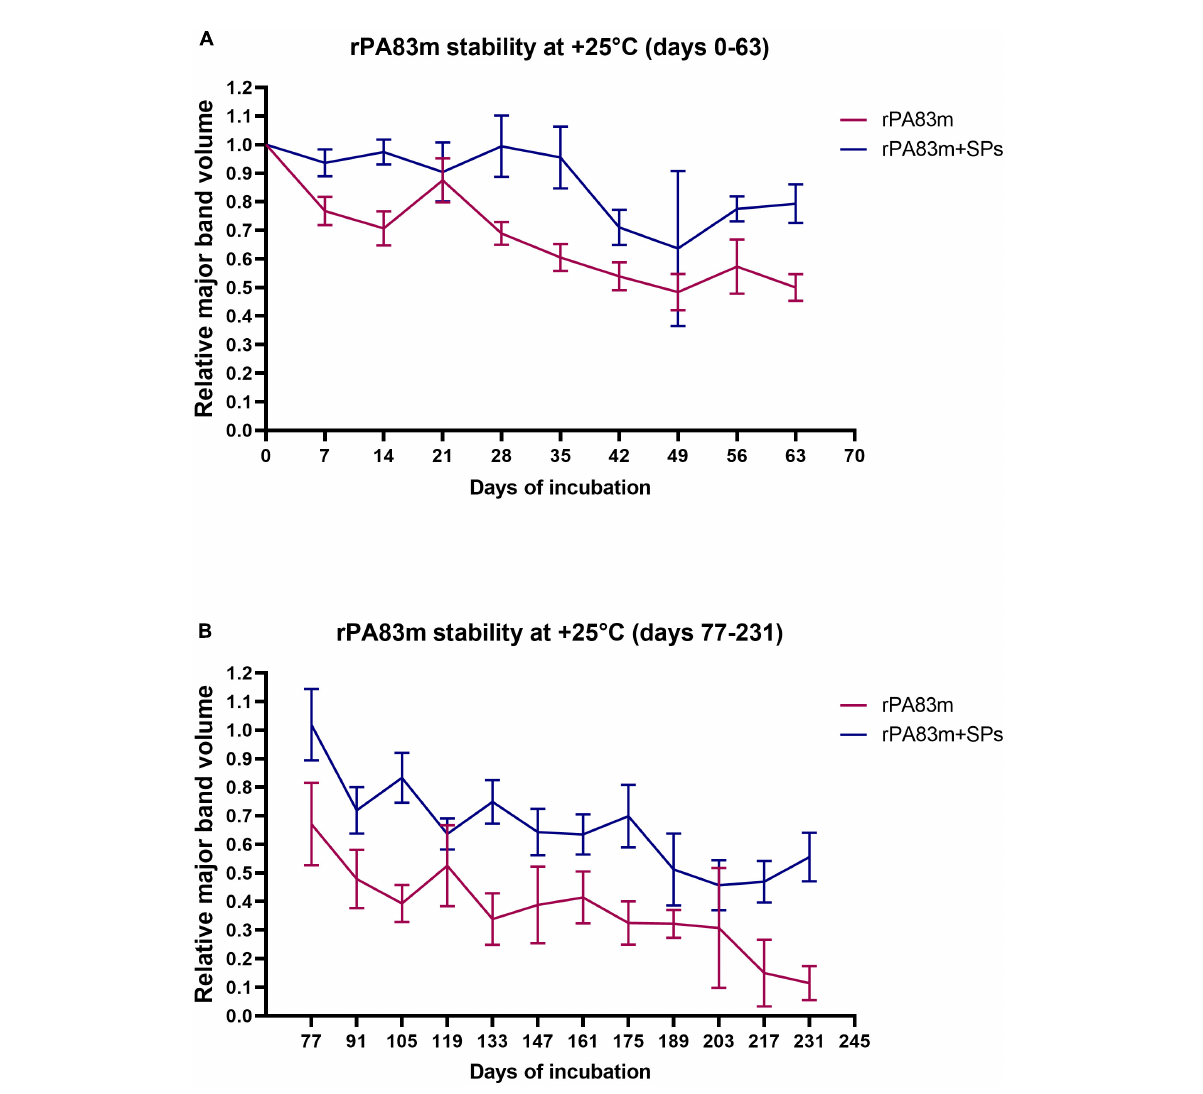
FIGURE2 Stability of individually formulated rPA83m and rPA83m as a part of rPA83m + SPs compositions at +25 ◦ C. Two independent stability evaluation experiments were carried out: for days 0–63 (A) and for days 77–231 (B) . In each experiment individually formulated rPA83m and rPA83m + SPs compositions were incubated at +25 ◦ C in PBS. In both cases, rPA83m concentration was 1 µ g/ µ l. rPA83m/SPs mass ratio was 1:10. For each checkpoint, relative major band volume means are presented for both individually formulated rPA83m (red) and rPA83m as a part of rPA83m + SPs compositions (blue) (the number of replicates was n = 5 except for rPA83m days 21, 91, 175, and 203 and rPA83m + SPs day 175, in which cases it was n = 4, 4, 3, 3, and 4, respectively). Stability evaluation for all incubated replicates was carried out by 8–20% SDS-PAGE analysis. For each replicate, the mean value of major band volumes determined by comparison with two corresponding non-incubated samples was used for graph plotting and group comparison. Bars represent 95%